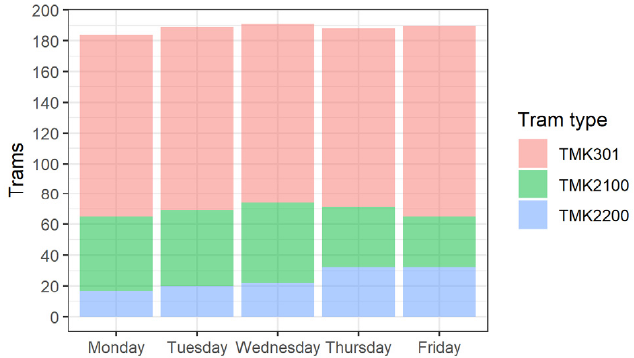
Figure 7. Daily distribution of trams by tram type in the observation period.